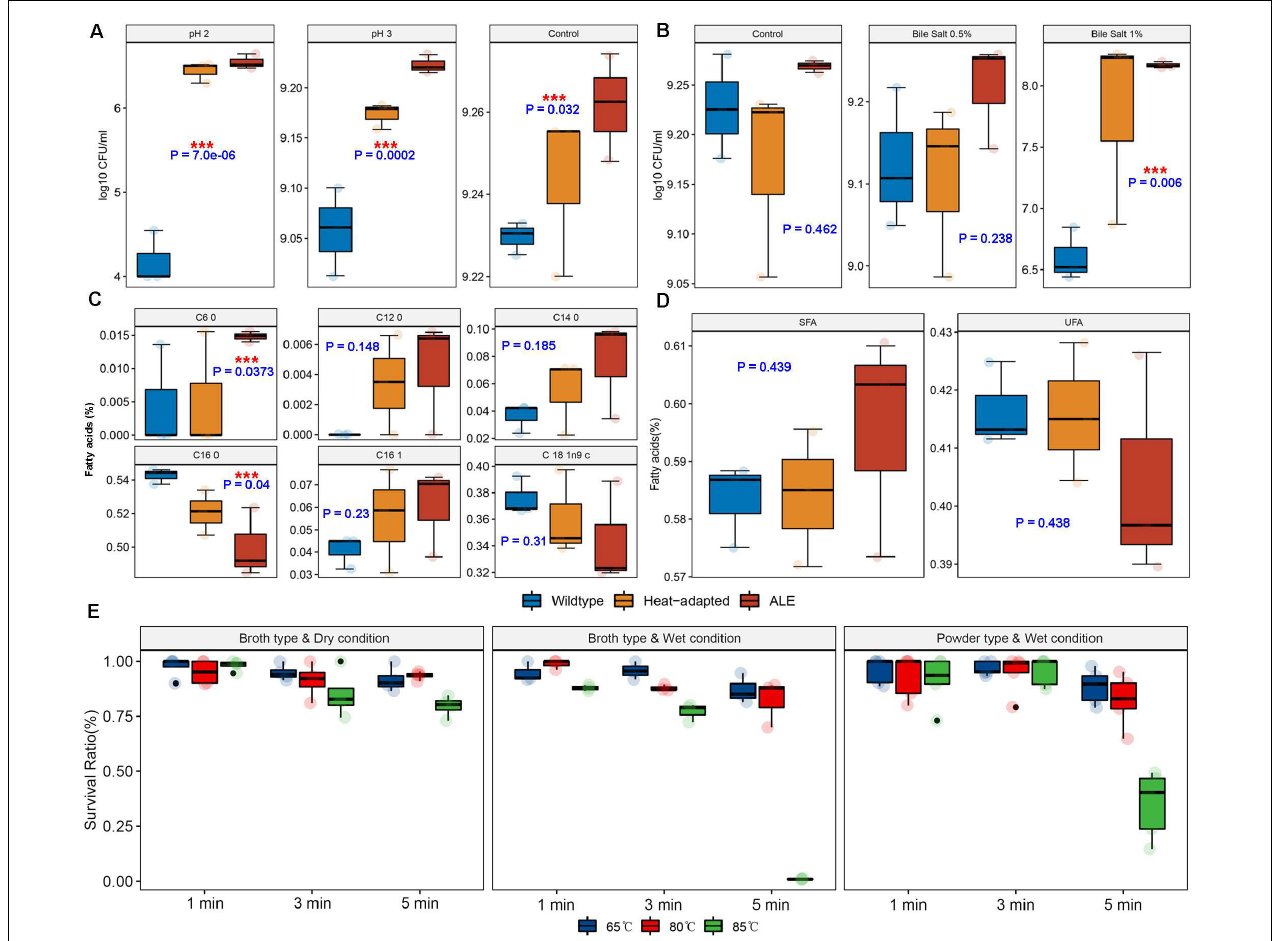
FIGURE 5 | Investigation of survival rate under various conditions. P -values of the contrast test between WT vs. ALE group in one-way ANOVA model. (A) Change in survival rate under various acidity conditions. (B) Change in survival rate under various bile salt conditions. (C,D) Comparison of fatty acid compositions among BIOPOP-3 WT, heat-adapted, and ALE strains. (E) Tolerance limits for various conditions including packaging (broth/powder), humidity (wet/dry), temperature and exposure times important for feed manufacturing